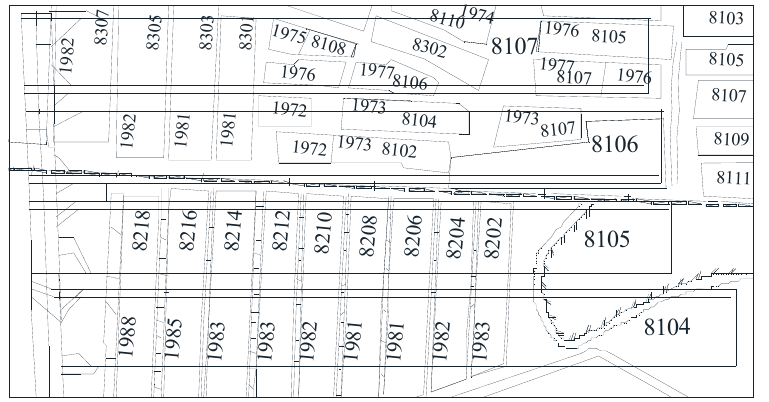
Figure 1. Plane layout of Jurassic and Carboniferous coal seams.